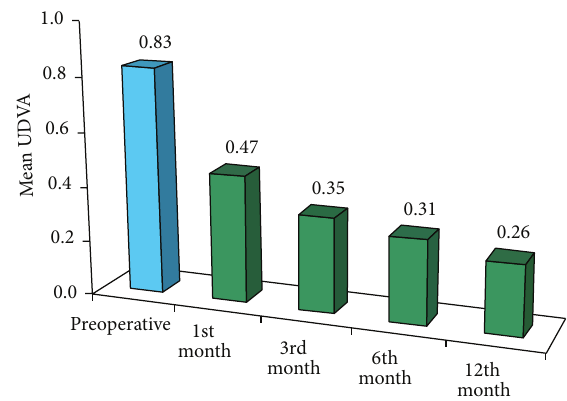
Figure 1: Preoperative and postoperative uncorrected distance vis- ual acuity.